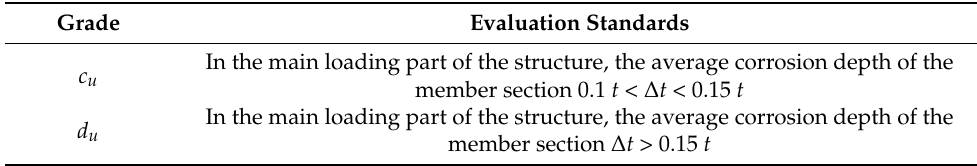
Table 8. Evaluation of corrosion of steel structural members unsuitable for carrying